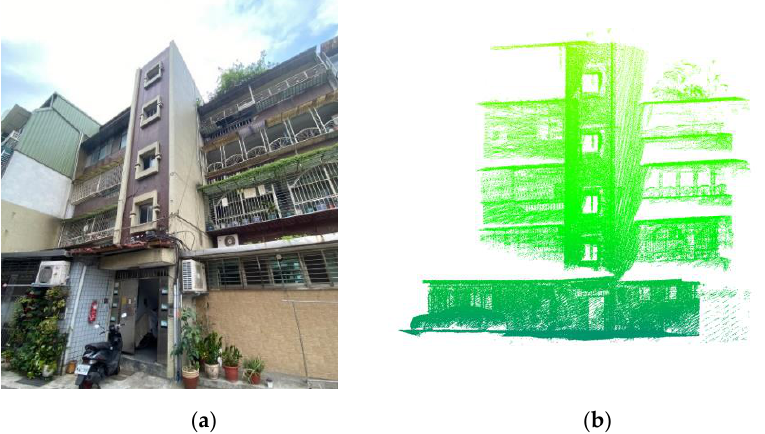
Figure 19. An example of the possible cadastral detail line between townhouses. ( a ) The digitized possible cadastral detail lines. ( b ) Overlap of point cloud and the cadastral map.